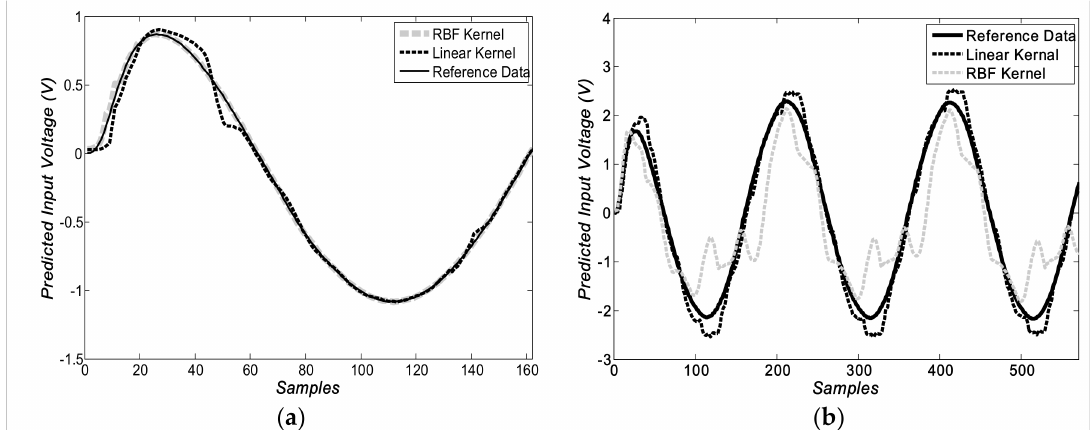
Figure 20. Comparison of the results of Model 2 and Model 8 when ( a ) tested with trained data; ( b ) tested with Data #10.